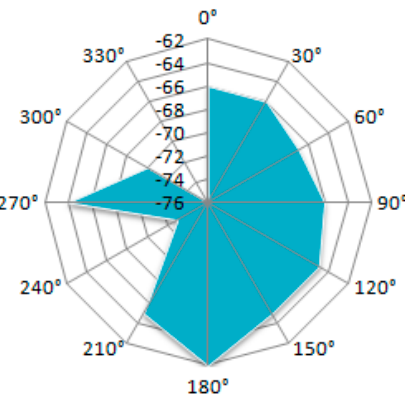
Figure 20. RSSI level vs. node orientation in a back-to-back measurement setup.